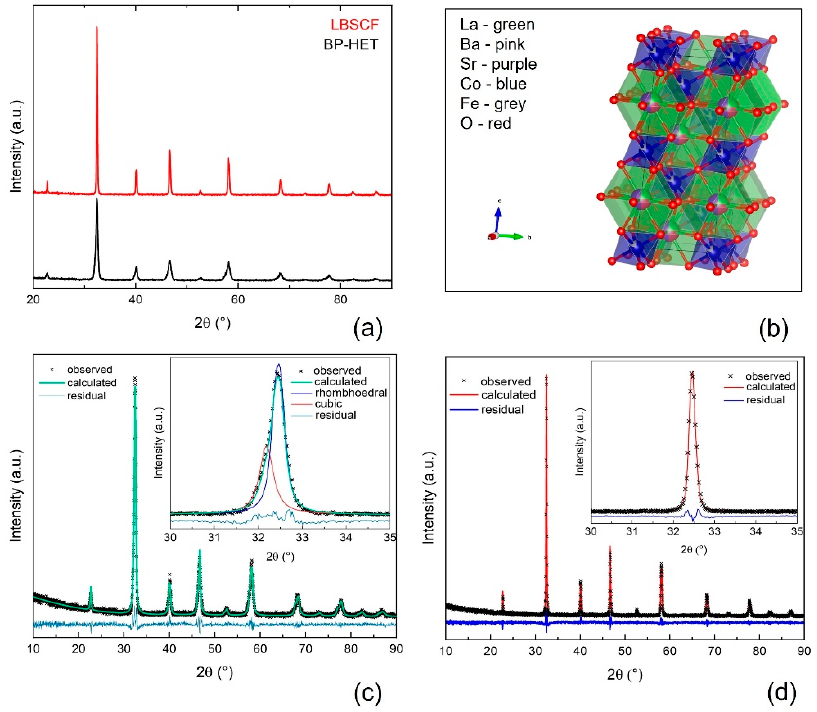
Figure 1. Panel ( a ): XRD patterns of BP-HET and LBSCF; Panel ( b ): Graphical representation of LBSCF phase extracted by Rietveld refinement; Panel ( c ): Graphical result of Rietveld refinement of BP-HET; black crosses: observed data; red line: calculated data; blue line: residual; Panel ( d ): Graphical result of Rietveld refinement of LBSCF; black crosses: observed data; red line: calculated data; blue line: residual.